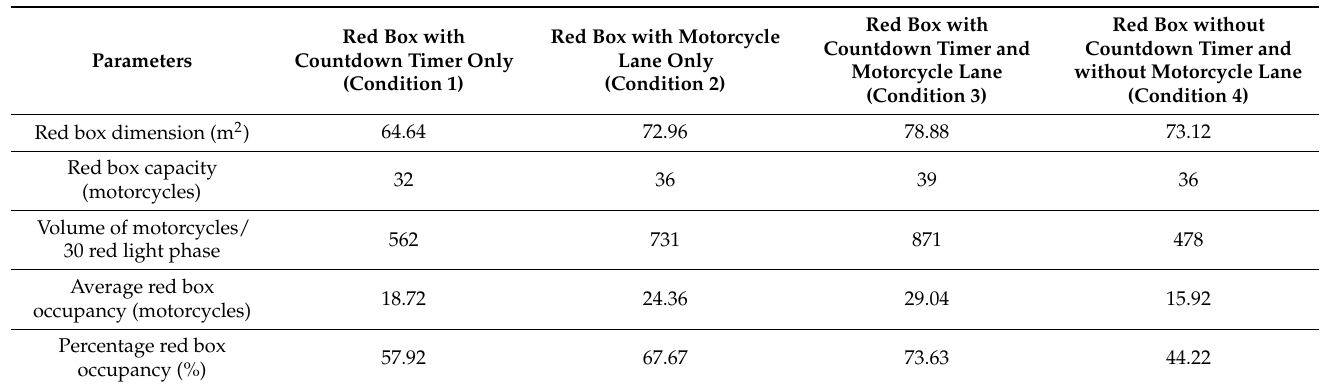
Table 3. Red box occupancy to the capacity.